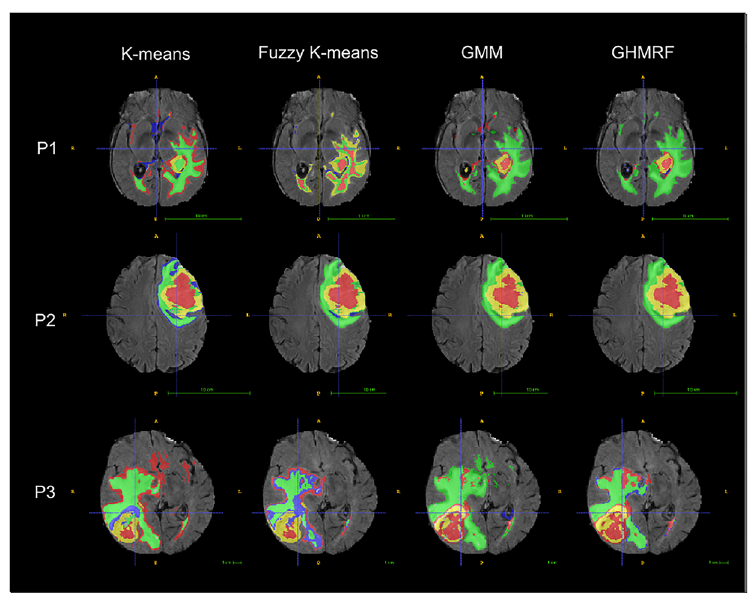
Fig 6. Examples of final segmentations of 3 patients of BRATS 2013 dataset computed by the different unsupervised